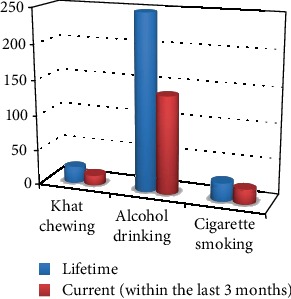
Distribution of substance-related factors among high school students at Aksum town, 2019 (n = 624).